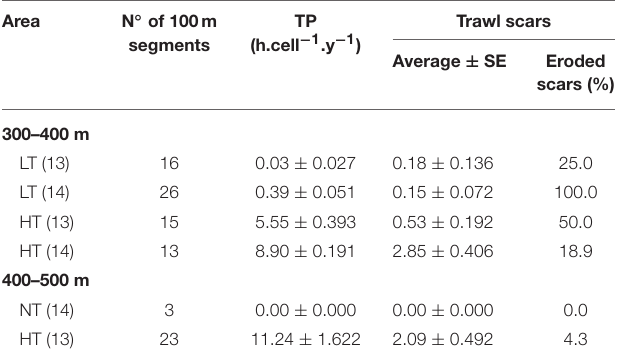
TABLE 3 | Characterization of the trawling scars observed in muddy-sand sediment (A6:4) segments within 300–400 and 400–500m water depths (selected dataset).